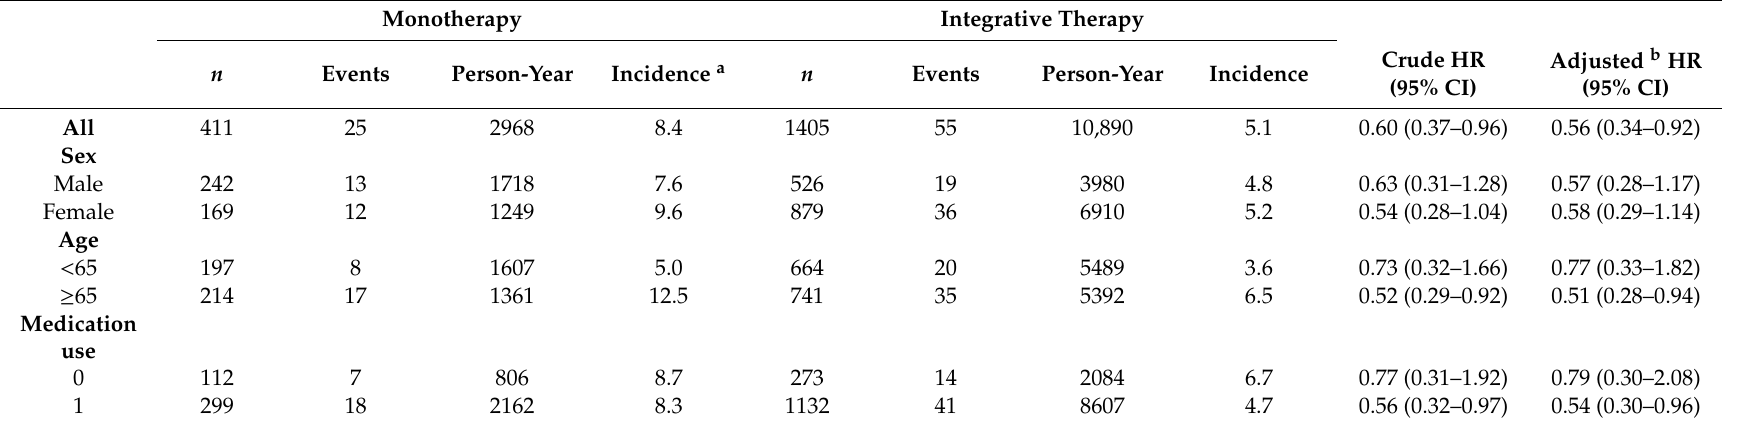
Table 2. Risk of PD in patients with IBD according to KM